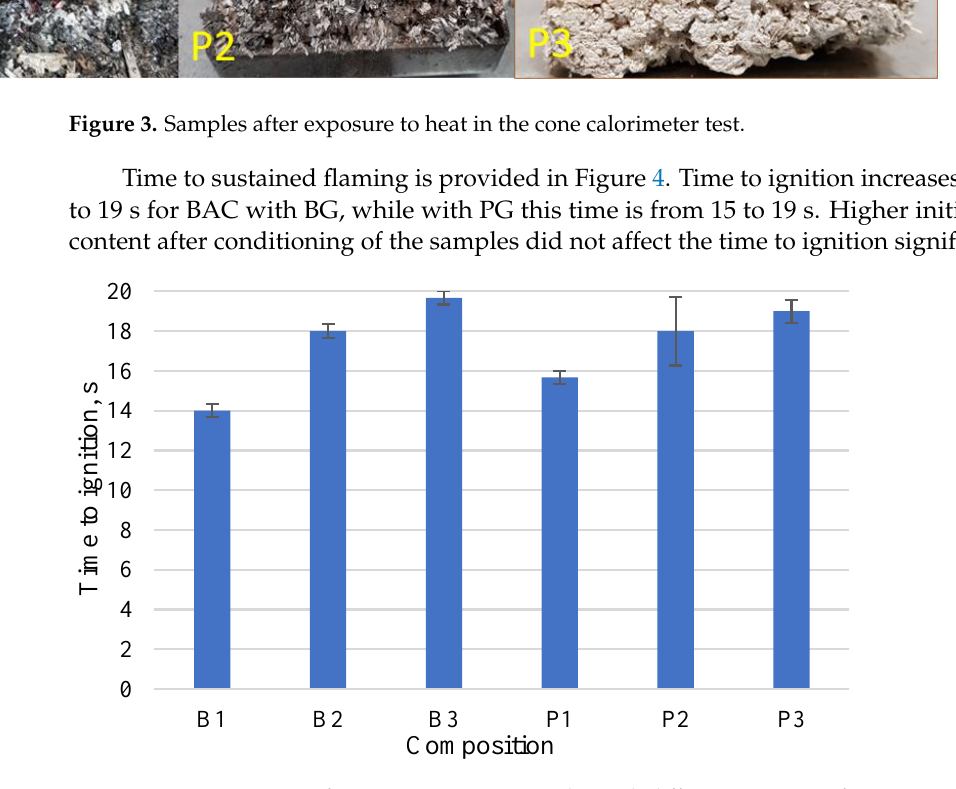
Figure 4. Time to ignition for BAC. B1 to B3—samples with different amounts of commercial gypsum, P1 to P3—samples with different amounts of phosphogypsum.